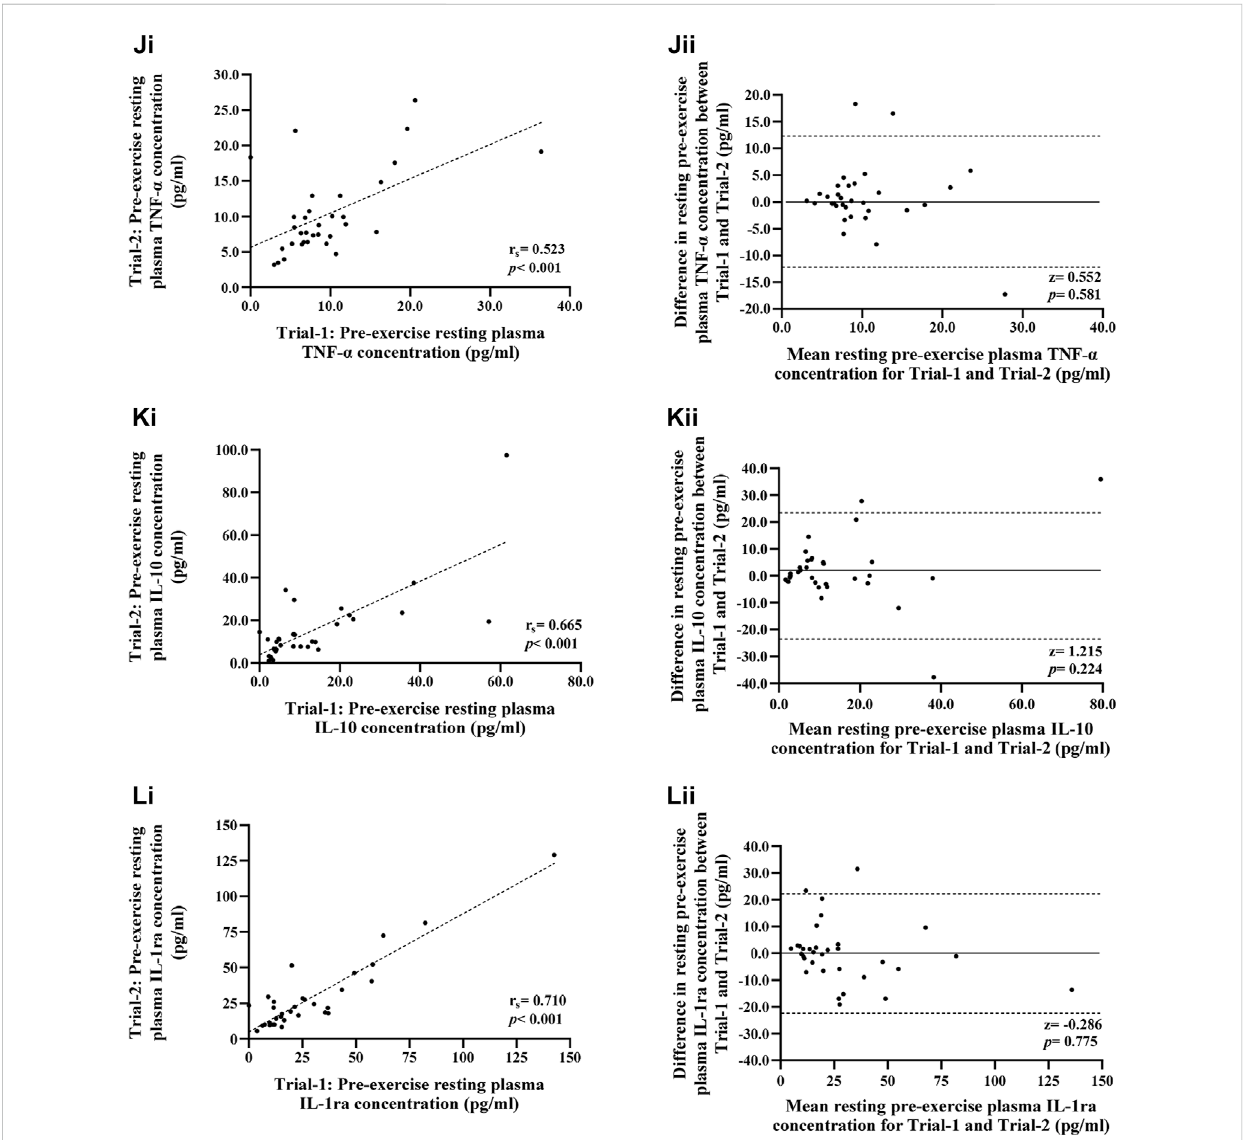
FIGURE 2 Correlation i) and Bland-Altman plot ii) comparing combined data from Trial-1 and Trial-2 for resting pre-exercise plasma cortisol (A) , I-FABP (B) , sCD14 (C) , and LBP (D) concentration; total leukocyte (E) and neutrophil counts (F) ; total bacterially-stimulated elastase release (G) and elastase